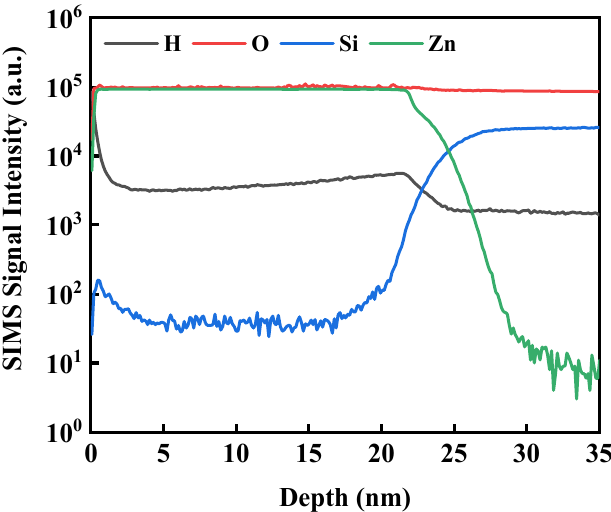
Figure 2. SIMS depth profiles of 20 nm ZnO:H thin film deposited at H 2 /(Ar + H 2 ) =